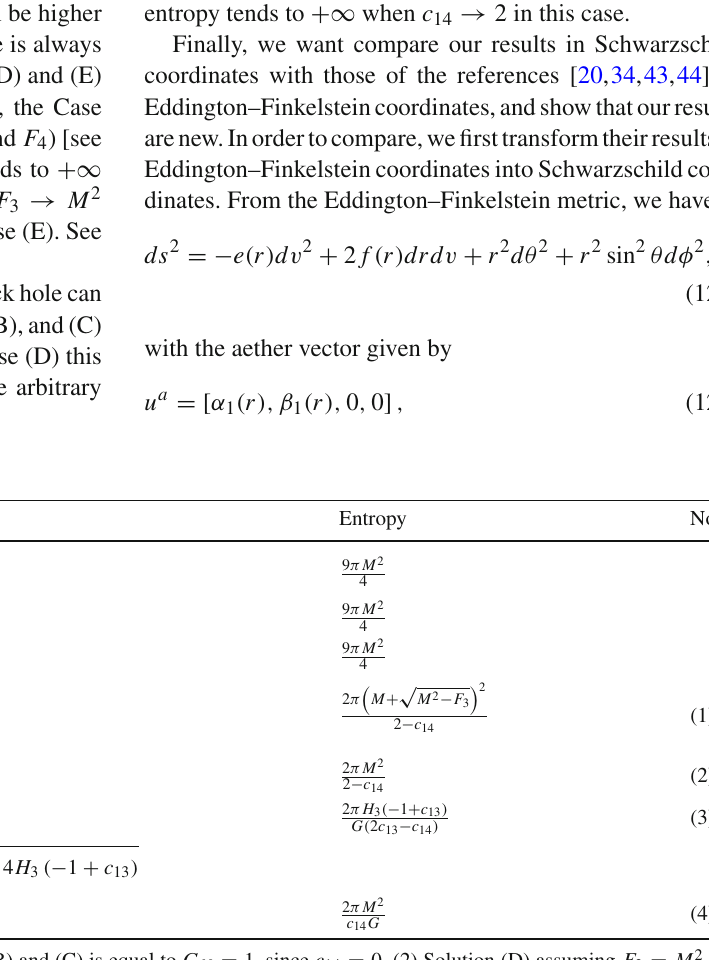
Table 4 Summary of the results of Eddington–Finkelstein coordinates transformed into Schwarzschild coordinates [20,34,43,44] Cases Metric